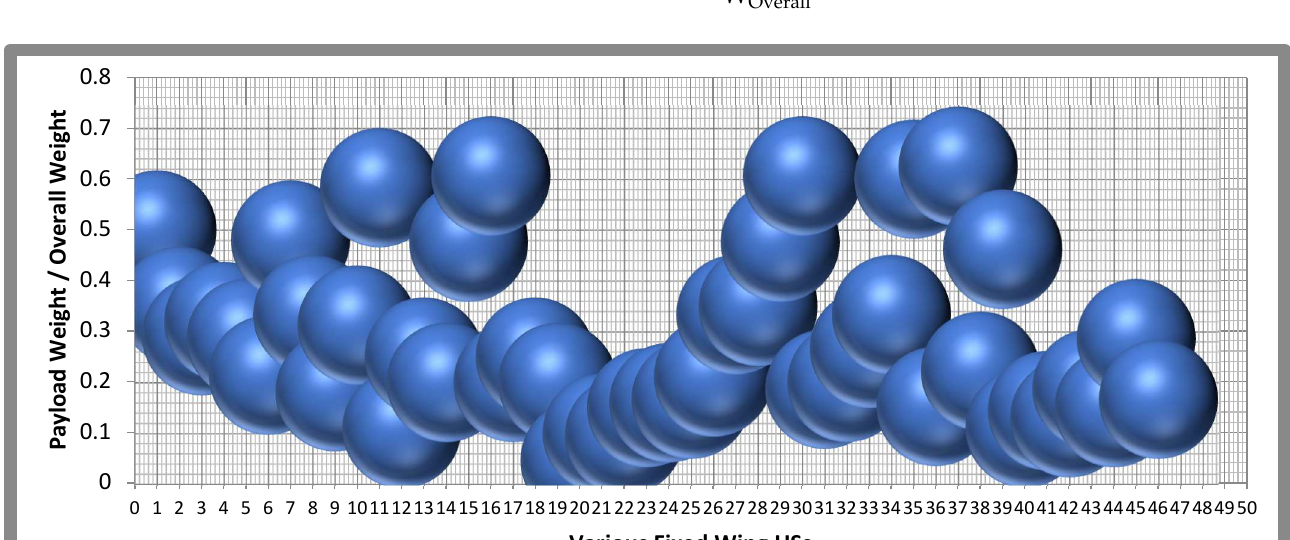
Figure 2. A typical comprehensive report of historical relationships between payload weight and overall weight of the USs.